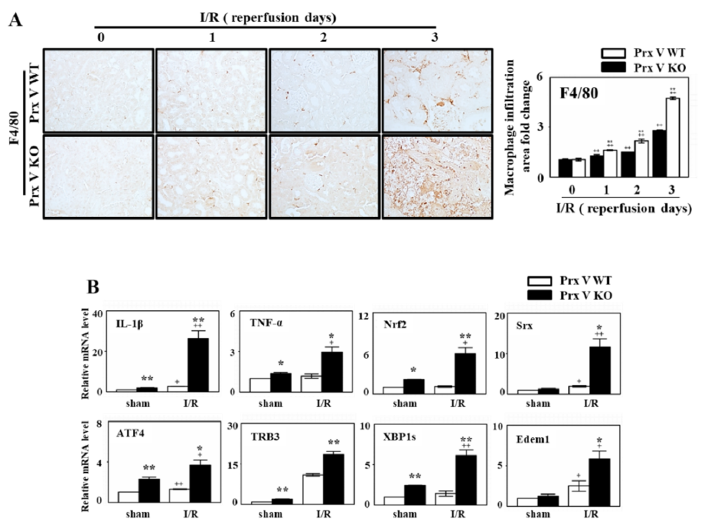
Figure 4. Effect of Prx V ablation on macrophage infiltration and oxidative stress-related mRNA levels during renal I/R . ( A ) The kidney sections were subjected to IHC with antibodies to F4/80 as macrophage marker. NIS-Elements AR 3.1 software was used to quantify. Graph is relative macrophage (F4/80) infiltration area fold change. Original magnification, 400× ( B ) The mRNA expression level of oxidative stress, ER stress and apoptosis-related genes in the mice kidney. Data are shown as means ± SE. n = 5–6 * p < 0.05 vs. WT, ** p < 0.01 vs. WT, + p < 0.05 vs. sham, ++ p < 0.01 vs. sham.